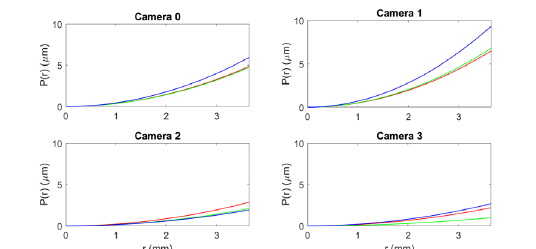
Figure 12. Case 1 Go Pro Hero 5 decentring lens distortion